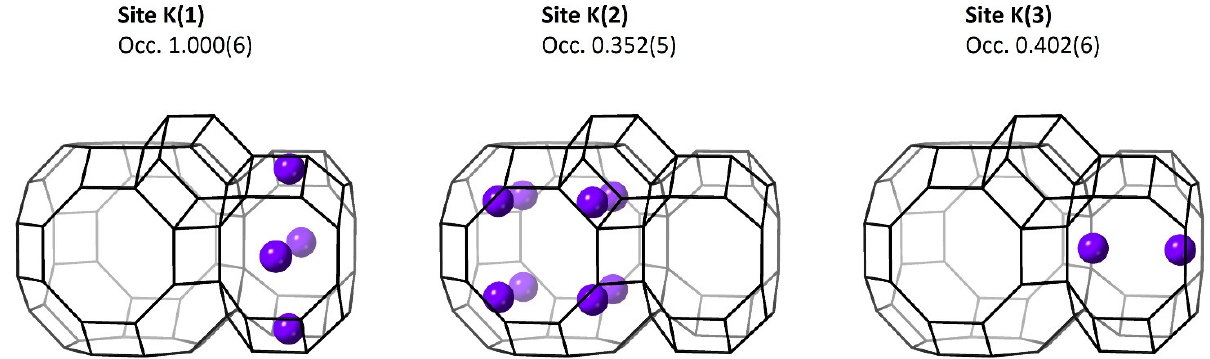
Figure 6. Location of the K(1)-K(3) cations sites determined in the empty zeolite ZK-5. The framework is shown as a stick model and the potassium cations as purple spheres. The fractional occupancy (Occ.) of each site is also included.